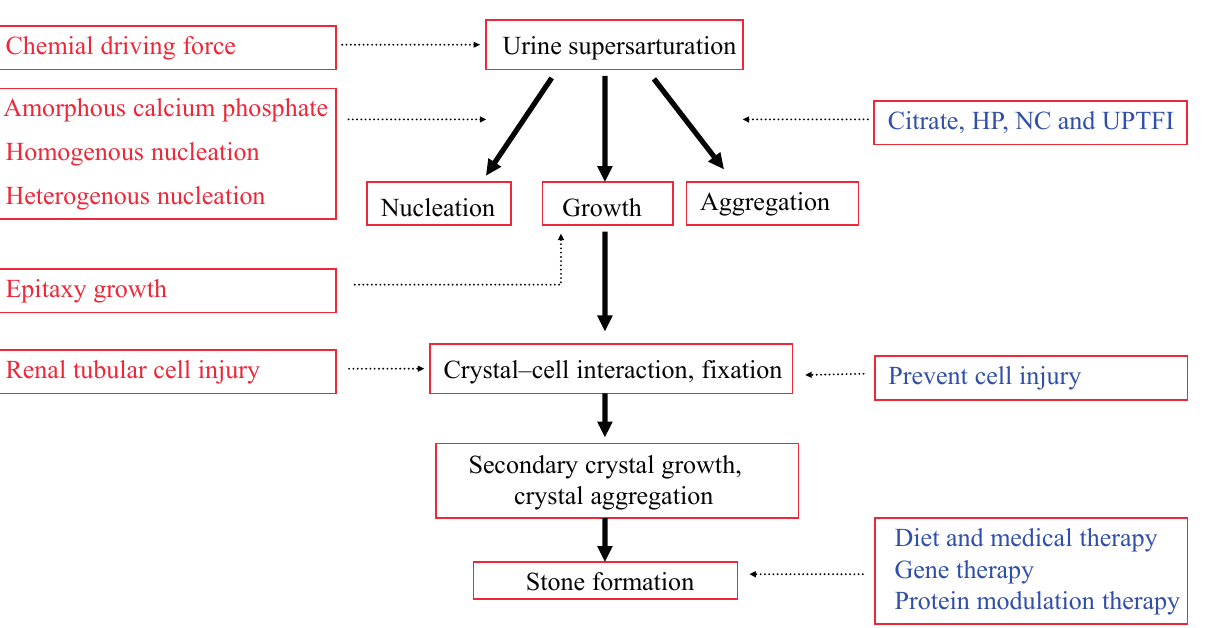
Figure 8. Schematic diagram for the formation and inhibition mechanism of calcium oxalate renal stone